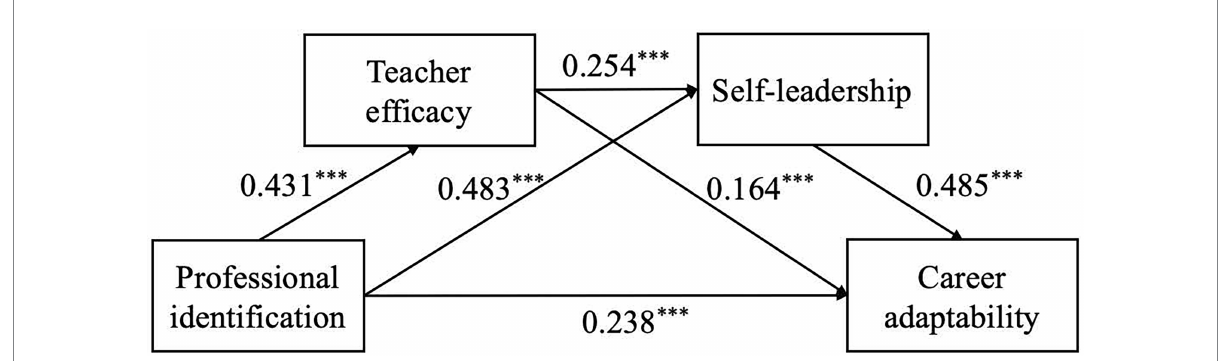
FIGURE 2 The chain mediating effect of teacher efficacy and self-leadership. *** p < 0.001.